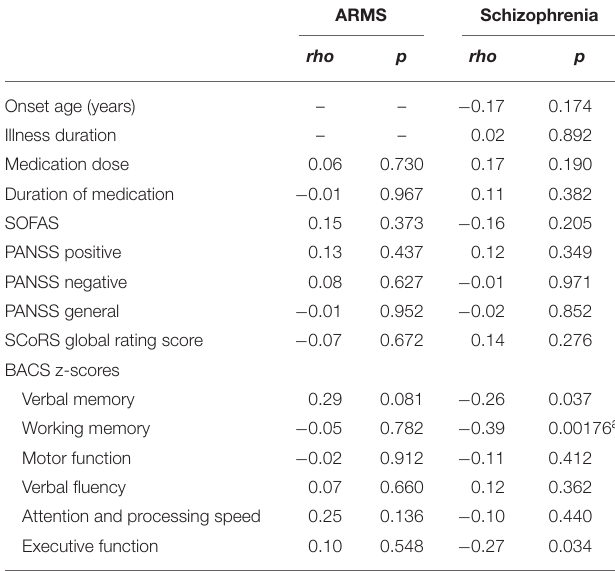
TABLE 2 | Correlations between the pituitary volume and clinical/socio-cognitive